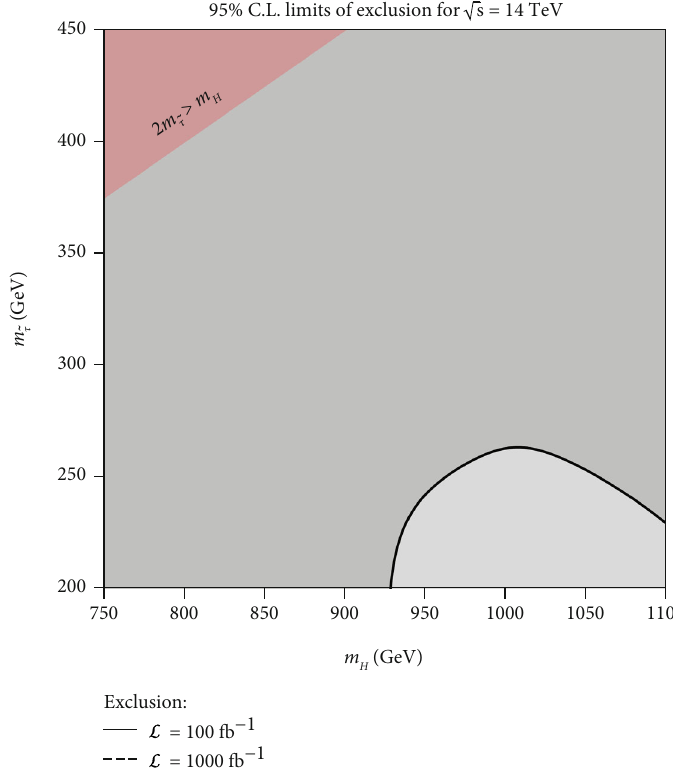
ffiffi p = 14 TeV. The area above the full line, s < 200 GeV. The 1 ~ τ ∗ is kinematically 1 1